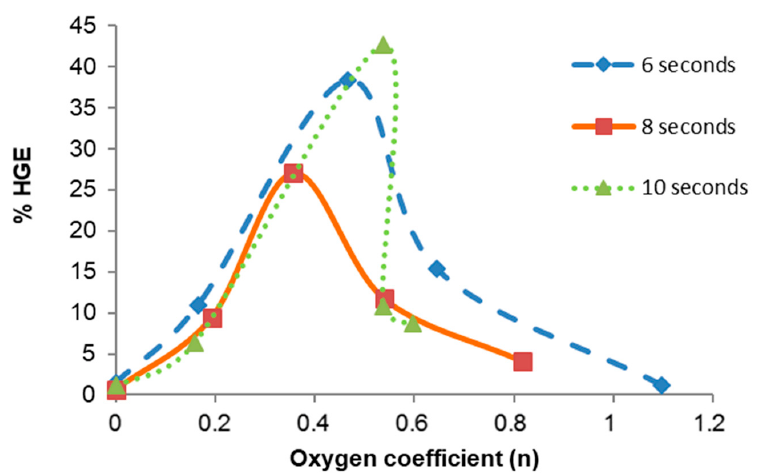
Figure 5. E ff ects of the oxidant on the SCWG of cellulose at 535 ◦ C, 250 bar and with an initial Figure 5. Effects of the oxidant on the SCWG of cellulose at 535 °C, 250 bar and with an initial concentration of cellulose = 0.3 g cellulose / concentration of cellulose = 0.3 g cellulose/L.